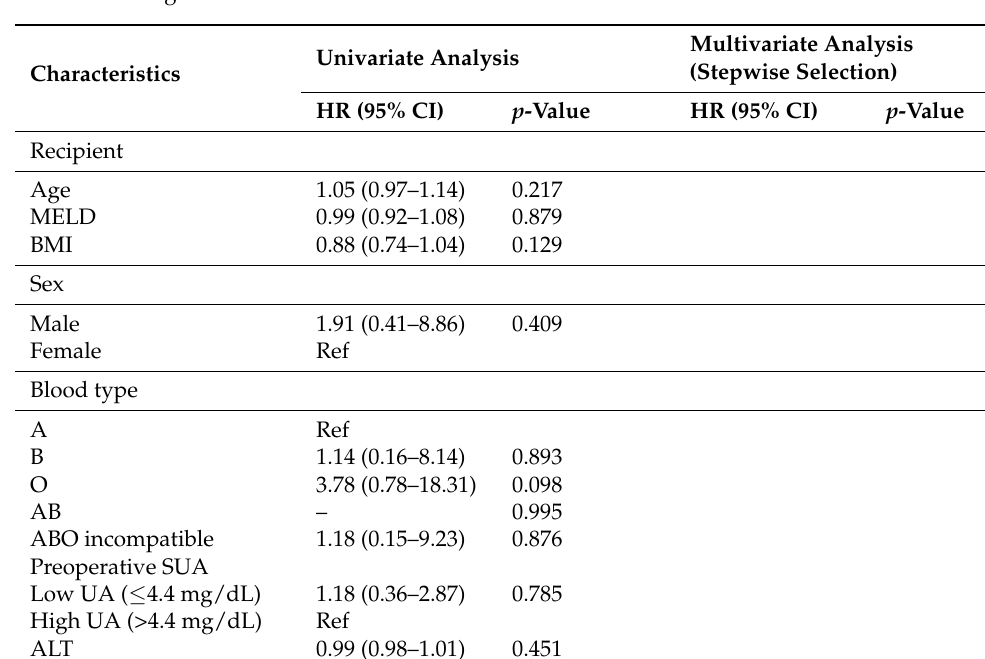
Figure 4. The one year survival curves of EAD versus non-EAD patients. EAD, early allograft dysfunction. Table 5. Cox